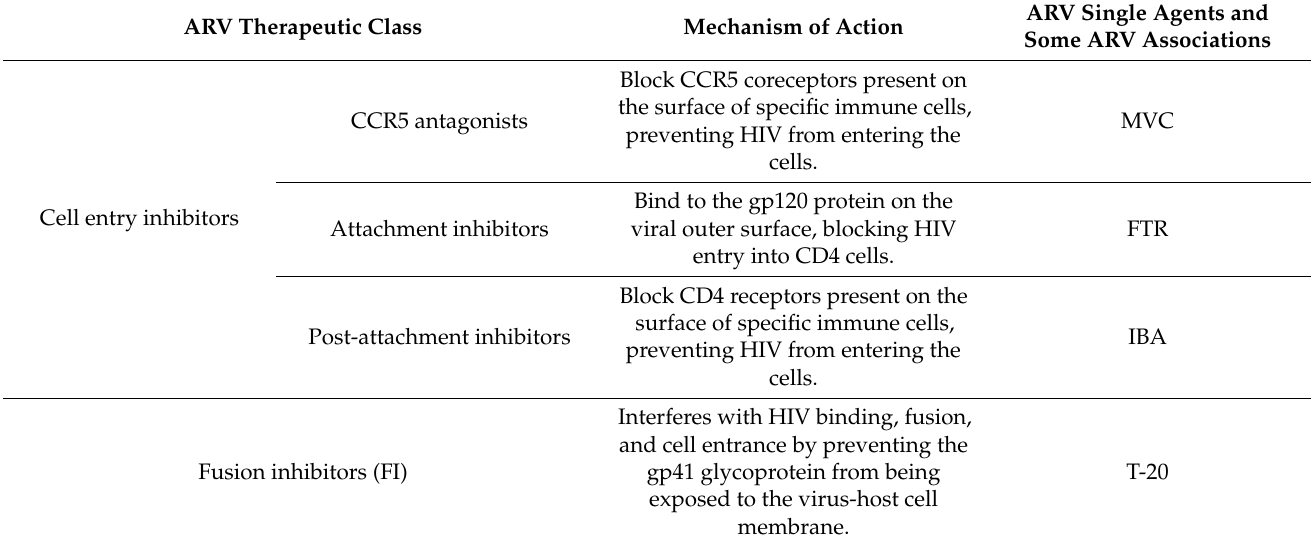
Table 1. ARV agents are classified into therapeutic classes based on their mechanism of action and target site [31,33,34]. ARV Therapeutic